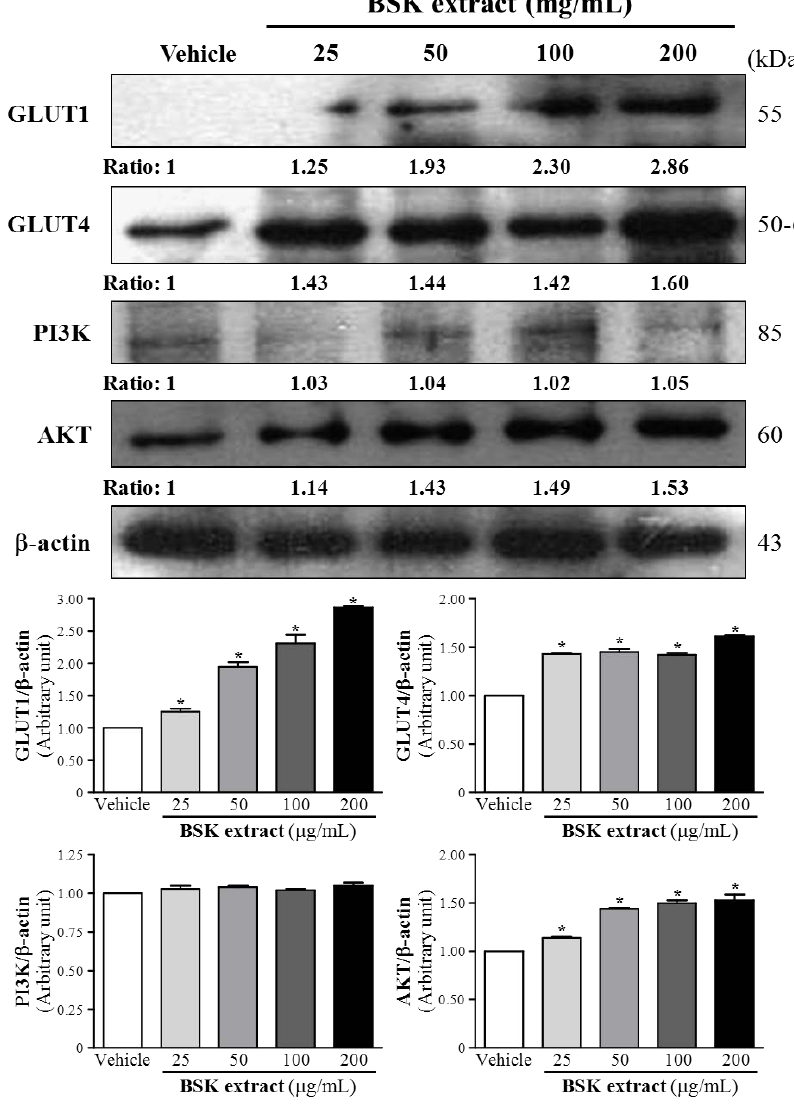
BSK promoted glucose utilization in 3T3-L1 preadipocytes directly by elevating GLUT1 and GLUT4 expression. Figure 1. Western blot analysis of the effect of black soybean koji (BSK) extract on the protein expression of glucose transporter 1 (GLUT1), GLUT4, phosphatidylinositol-4,5- bisphosphate 3-kinase (PI3K) and protein kinase B (AKT) in 3T3-L1 preadipocytes. Preadipocytes were treated with vehicle (0.1% DMSO) or with different doses of BSK extract for 60 h. Data are mean ± SEM relative to vehicle treatment from 3 independent experiments. * p < 0.05 compared with